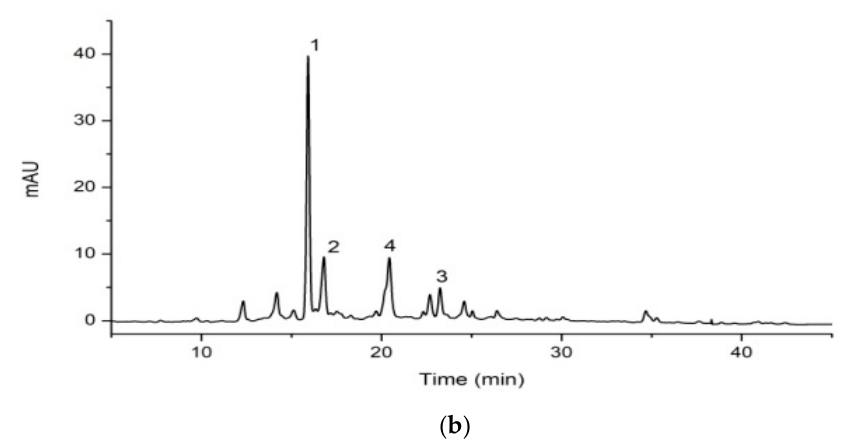
Figure 4. HPLC analysis of oligomeric procyanidins from litchi pericarp (LPOPC) from enzyme ( a )— or ultrasound ( b )—assisted extraction. Peaks 1–4 represented EC, A-3, A2, and A1, respectively.